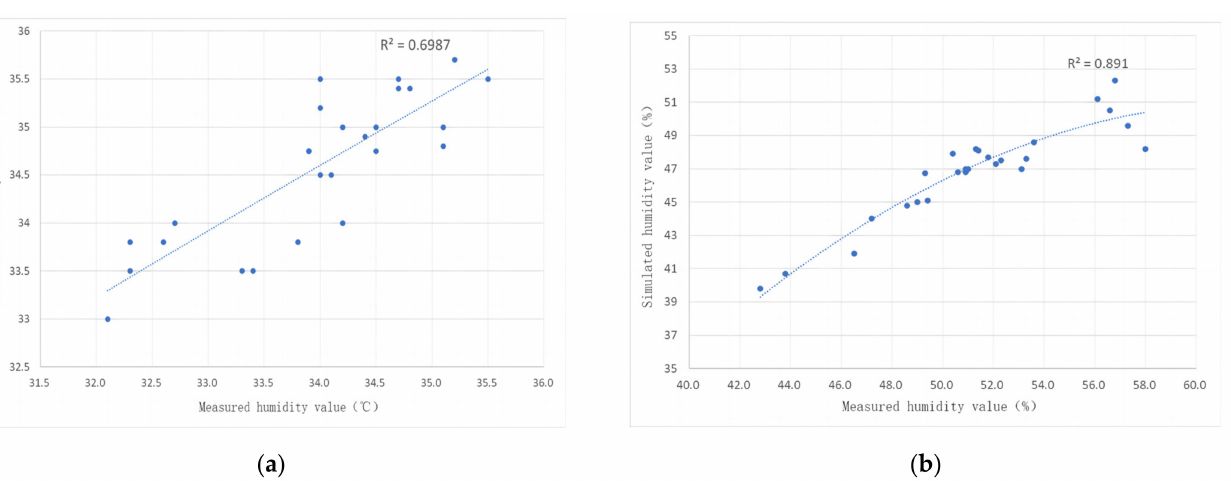
Figure 7. Correlation analysis between experiment and simulation: ( a ) air temperature; ( b ) relative